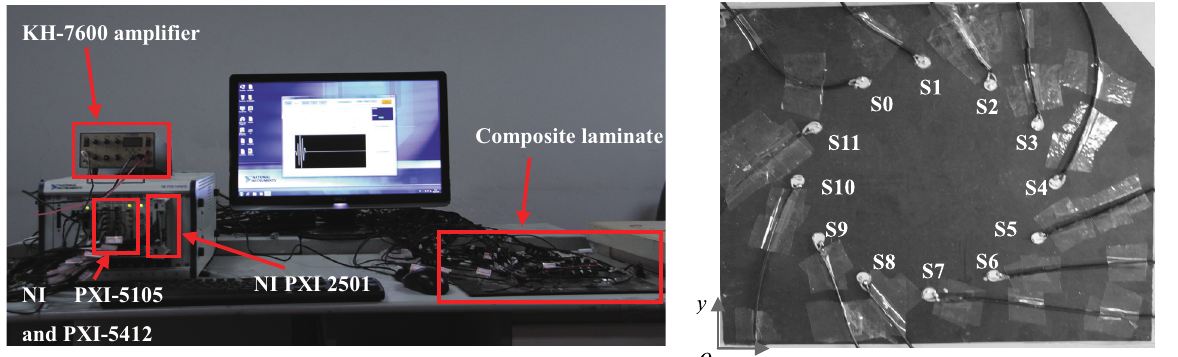
Fig. 3. A multi-channel PZT transducer-array scanning system. Fig. 4. A composite structure and transducer array.